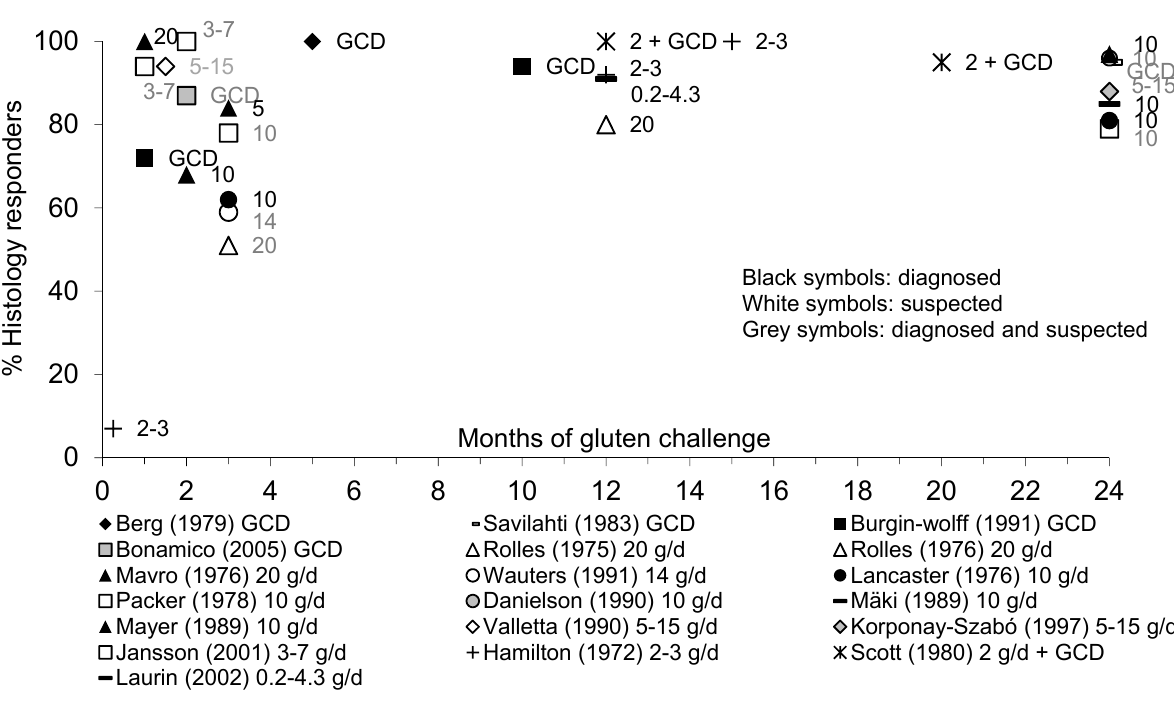
Figure 5. Percentage of pediatric patients with diagnosed or suspected CD showing histological response to gluten over